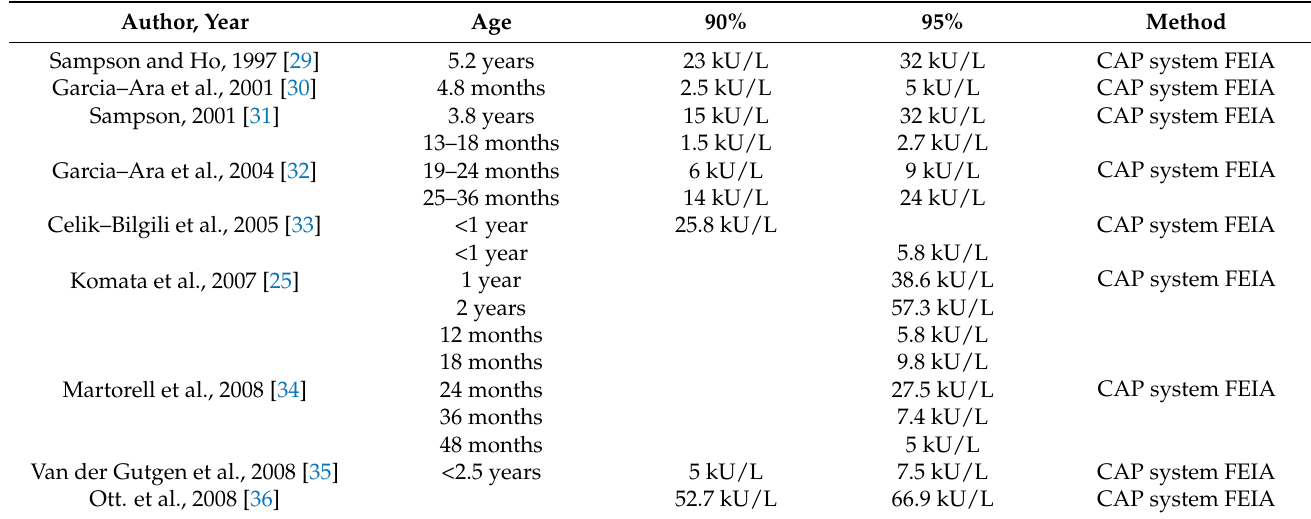
Table 2. Positive predictive values of 90% and 95% of sIgE levels for a positive